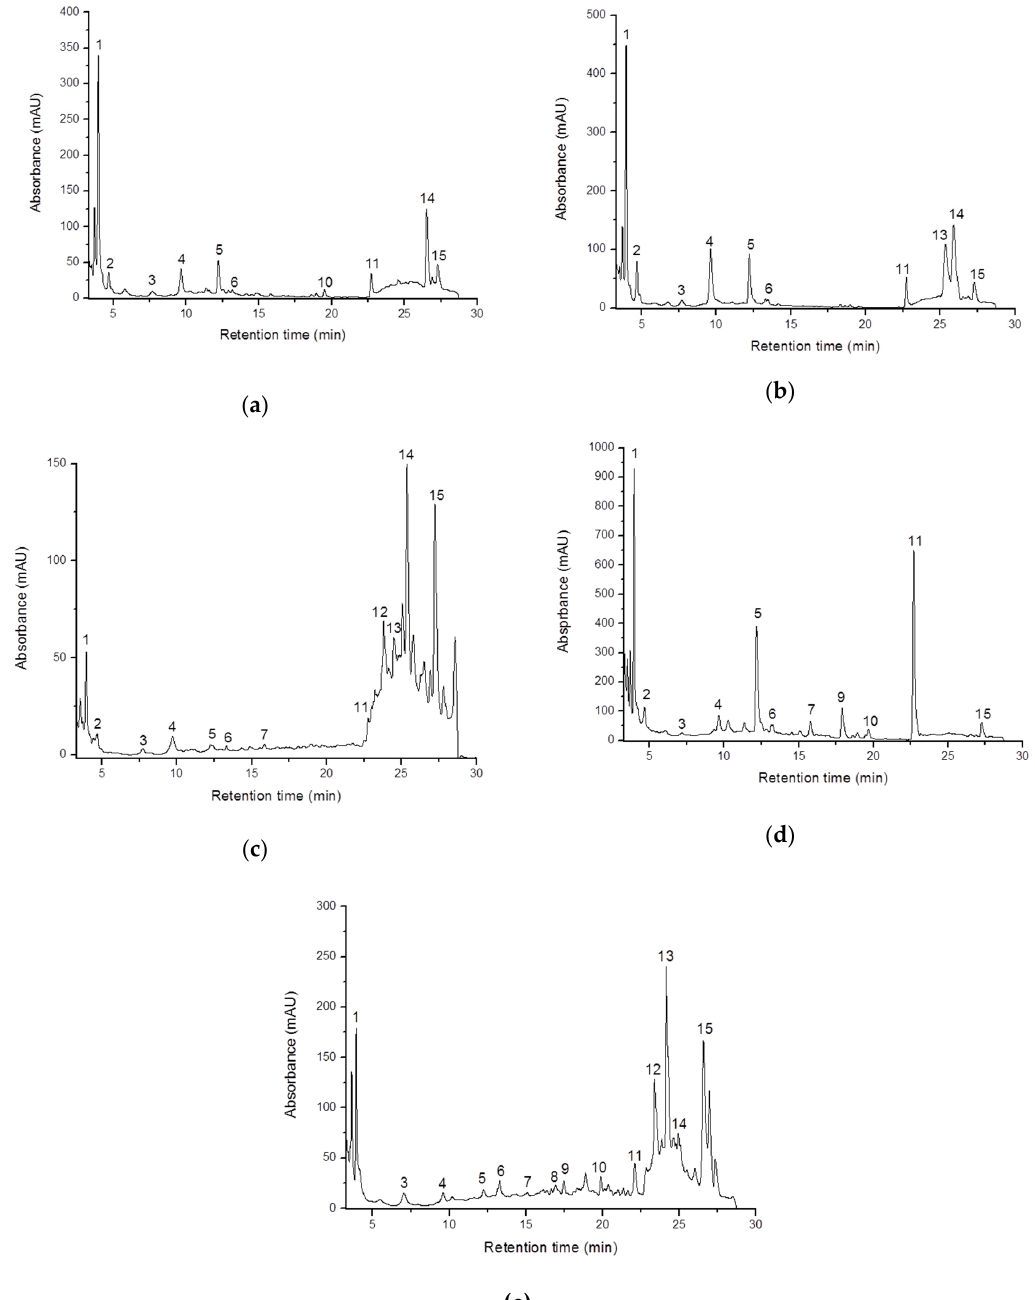
Figure 2. HPLC chromatograms of mushrooms extracts recorded at 280 nm: ( a ) Pleurotus ostreatus , ( b ) Agaricus bisporus , ( c ) Cantharellus cibarius , ( d ) Boletus edulis , ( e ) Lactarius piperatus . The numbering of the peaks refers to Table 4.